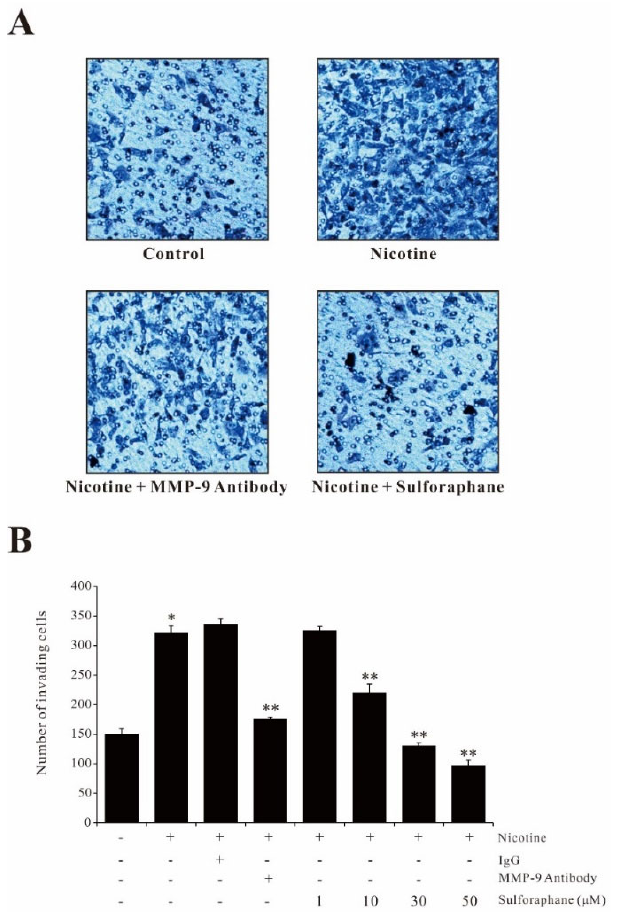
Figure 6. Sulforaphane inhibits nicotine-induced cell invasion in AGS cells. ( A ) AGS cells (3 × 10 5 ) were incubated with nicotine (100 µ g/mL) in the presence or absence of sulforaphane (30 µ M) or anti-MMP-9 antibody (200 ng/mL) in a Corning Matrigel matrix for 24 h. ( B ) AGS cells (3 × 10 5 ) were incubated with nicotine (100 µ g/mL) in the presence or absence of nonspecific IgG, anti-MMP-9 antibody (200 ng/mL), or sulforaphane (10, 30, 50 µ M) in a Corning Matrigel matrix for 24 h. Cells invading the undersurface of the membrane were stained using a Diff-Quick stain kit and counted under a phase-contrast light microscope. The data represent the mean ± SEM from three experimental trials. * p < 0.05 in comparison with the control; ** p < 0.05 in comparison with nicotine alone.